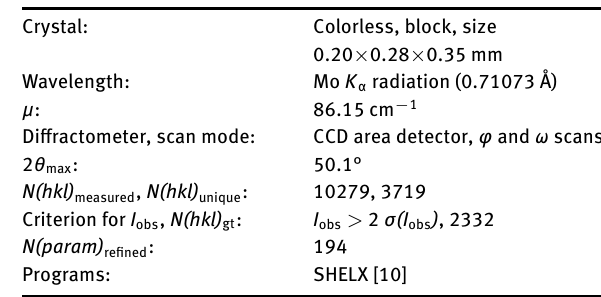
Table 2: Fractional atomic coordinates and isotropic or equivalent isotropic displacement parameters (Å 2